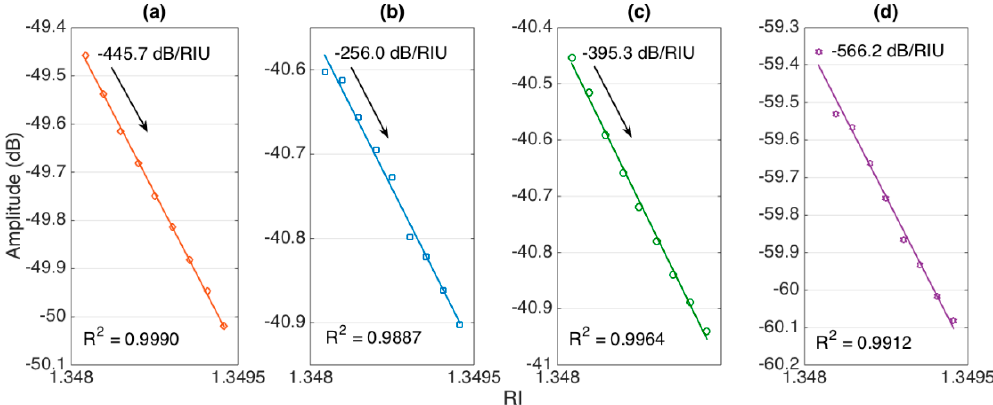
Figure 7. Evaluation of amplitude-level sensitivity for each ball resonator. The charts show the spectral amplitude of the spectral features for different RI values (1.34798 – 1.34922). The sensitivity was evaluated as the slope of linear regression, R 2 = coefficient of determination. Ball resonator diameters: ( a ) 547 µm; ( b ) 532 µm; ( c ) 494 µm; ( d ) 466 µm.